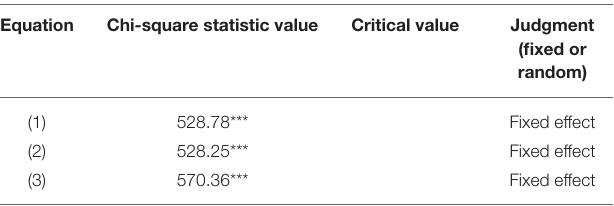
TABLE 5 | Hausman test results.